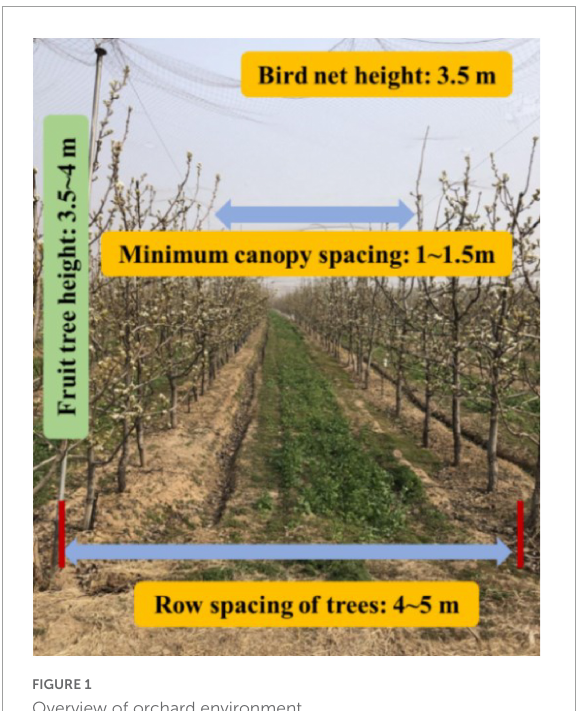
FIGURE1 Overview of orchard environment.